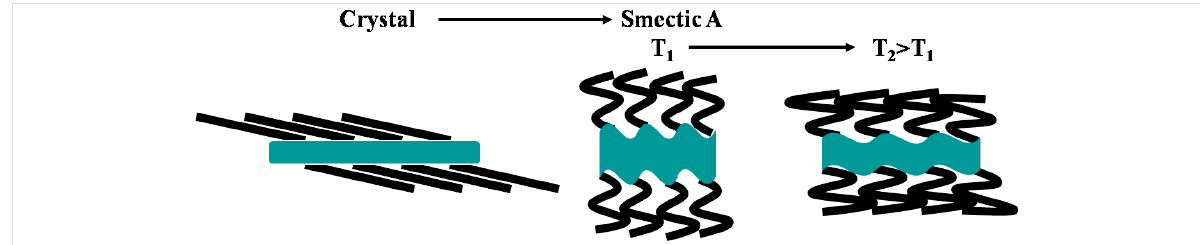
Figure 7: The melting process involves the ruffling of the ionic sublayer. In the smectic phase, the ruffling degree decreases with increasing temperature.